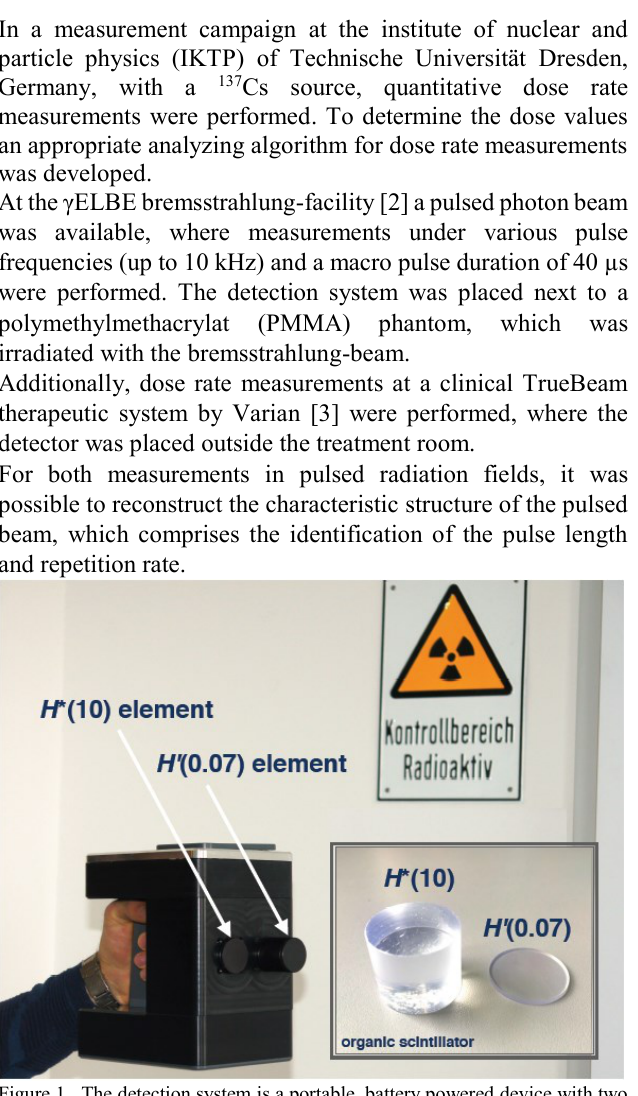
Figure 1. The detection system is a portable, battery powered device with two organic scintillation elements ( H *(10) element, and H ´(0.07) element) each coupled on an individual photomultiplier tube with a subsequent free running 14 bit analog-to-digital converter with a sampling rate of 125 MHz for